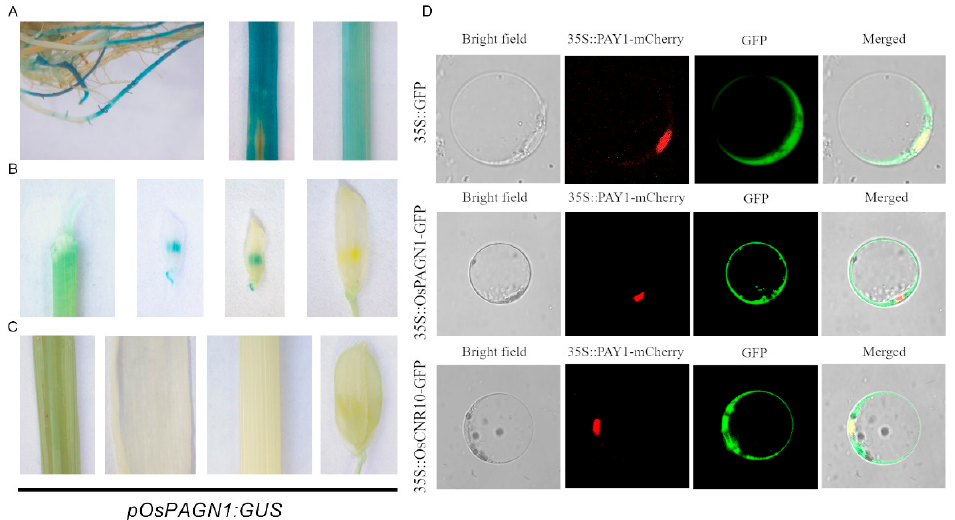
Figure 3. OsPAGN1 expression patterns. ( A – C ) OsPAGN1 promoter activities in rice tissues as determined by promoter–GUS assays. An approximately 2-kb sequence upstream of the ATG codon of OsPAGN1 was inserted upstream of the β -glucuronidase (GUS) reporter gene. ( A ) Representative roots, leaf, and stem at the three-leaf stage. ( B ) Spikelet of panicles 0.5, 2, 6, or 10 cm long. ( C ) Representative leaf, shoot, stem, and spikelet at the booting stage. ( D ) Subcellular localization of OsPAGN1 and OsCNR10 in rice protoplasts.